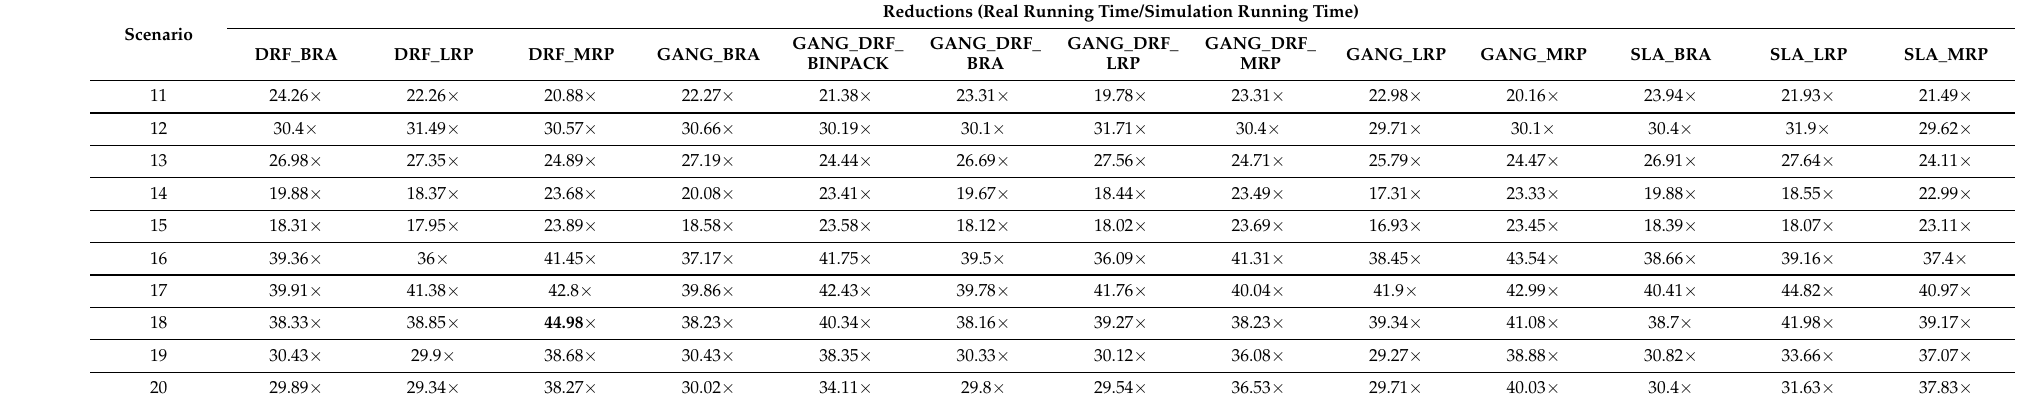
Table 5. Reductions in running time under JobQueue workloads and changeable